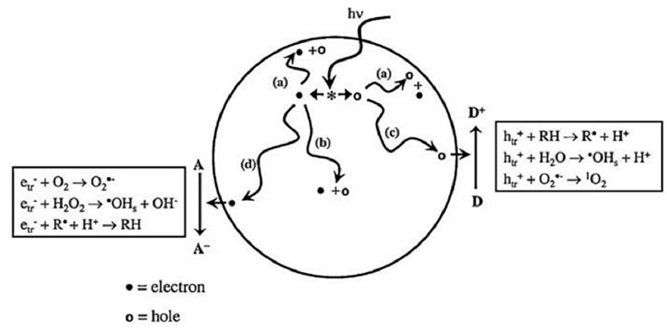
Figure 2. TiO 2 photocatalytic mechanism